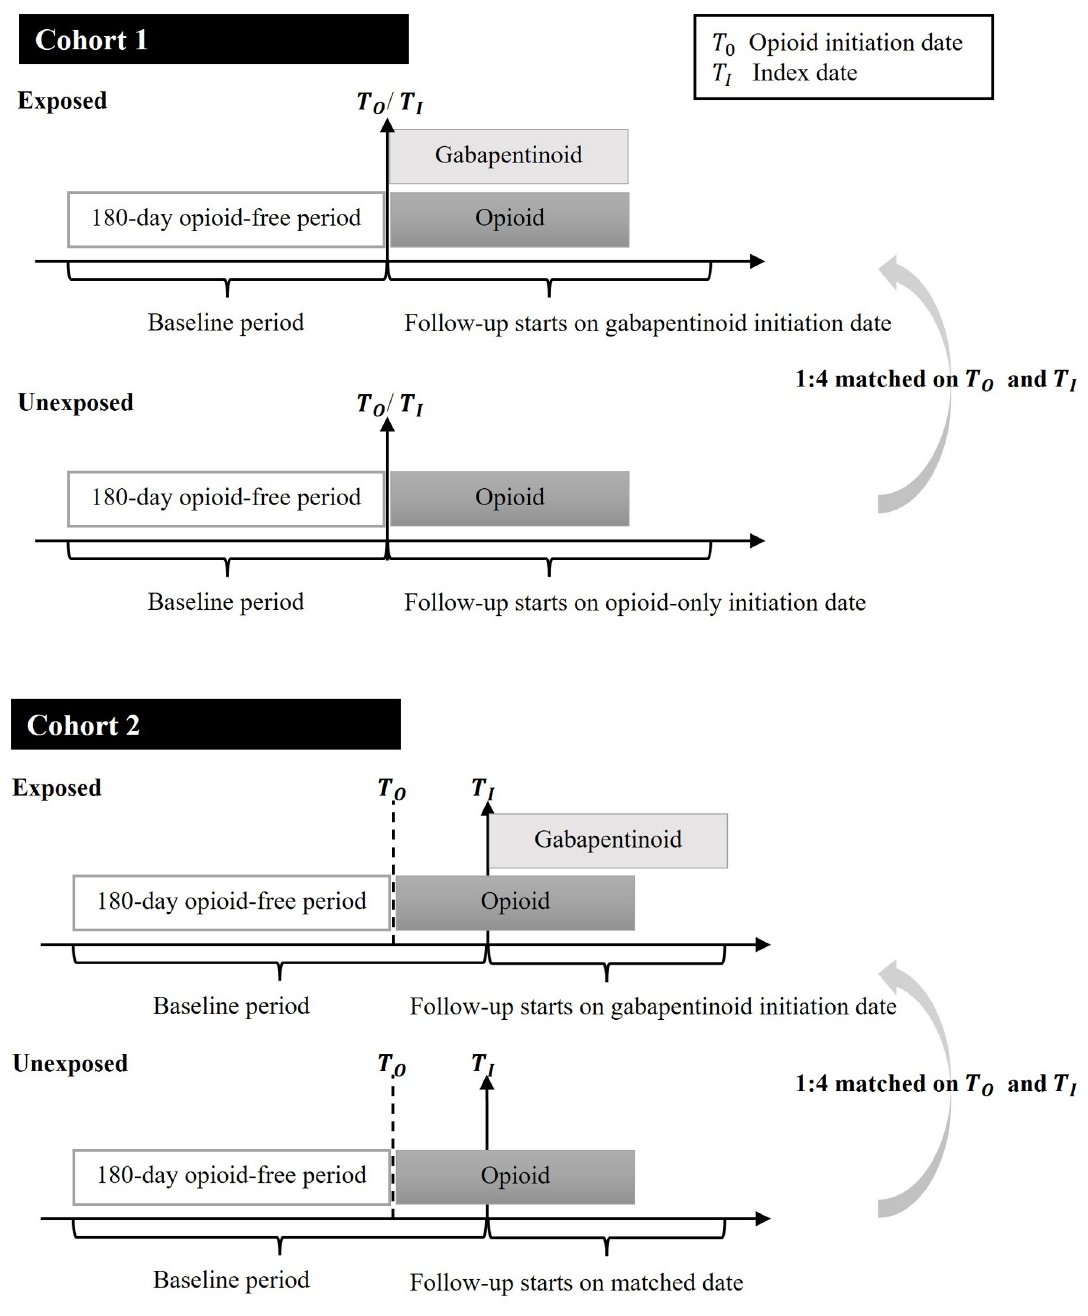
Fig 1. Description of 2 study cohorts of older adults with CNCP. The exposed group consists of concurrent gabapentinoid–opioid users, and the unexposed group consists of opioid-only users. T 0 indicates date of opioid initiation, i.e., date of first opioid prescription after a 180-day opioid-free period. T I indicates the index date, i.e., the beginning of follow-up. For the exposed group, T I is the first day of concurrency. In Cohort 1, T 0 and T I overlap. In Cohort 2, T 0 precedes T I . In both Cohort 1 and Cohort 2, each exposed patient is matched to up to 4 unexposed patients on T 0 and T I . CNCP, chronic noncancer pain.